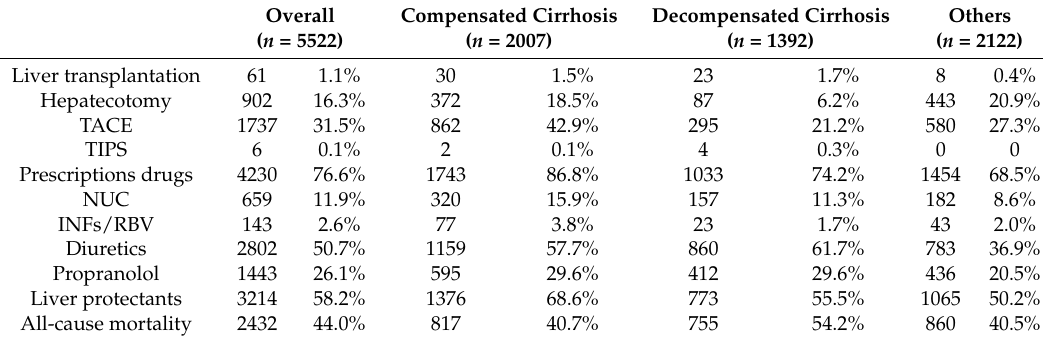
NUC = nucleoside/nucleotide; INFs = interferons; RBV = ribavirin; Others: other chronic liver disease. TACE = transarterial chemoembolization; TIPS = transjugular intrahepatic portosystemic shunt.